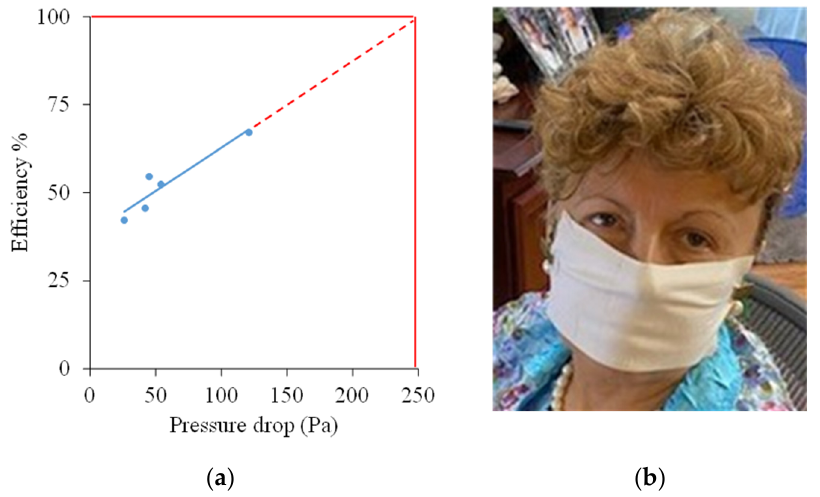
Figure 9. Correlation of filtering efficiency and pressure drop across the mats ( a ); potential COVID-19 mask ( b ).